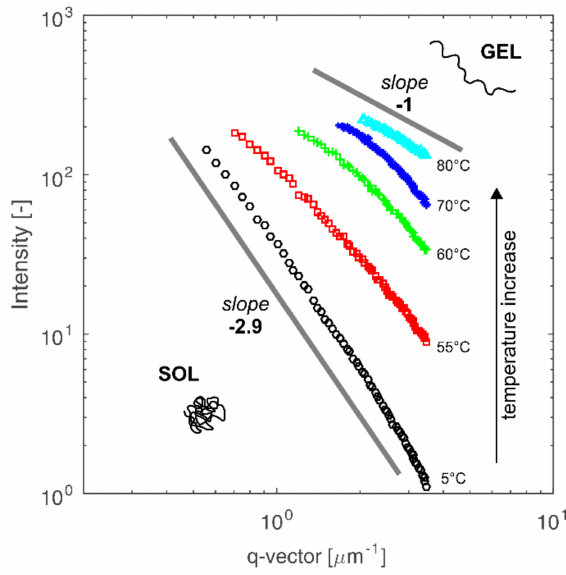
Figure 9. Dependence of intensity as a function of scattering vector in the log scale, enabling determination of exponent n. Data for the sample with concentration 2.5% ( w / w